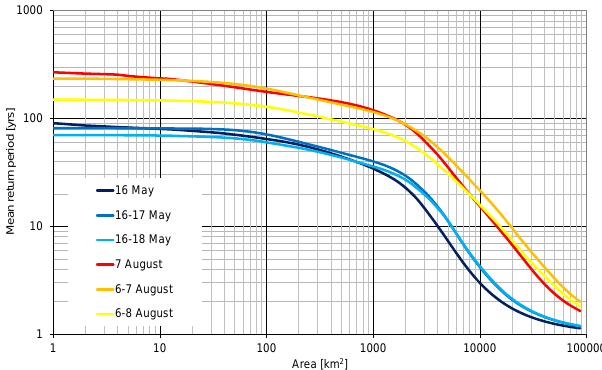
Fig. 5. Changes in geometric means of ordered return periods of precipitation totals in Fig. 4 as a function of increasing area.